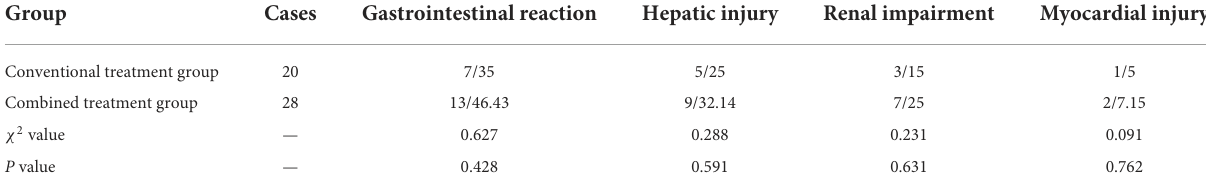
TABLE 4 Incidence of adverse reactions in both groups (cases/%).